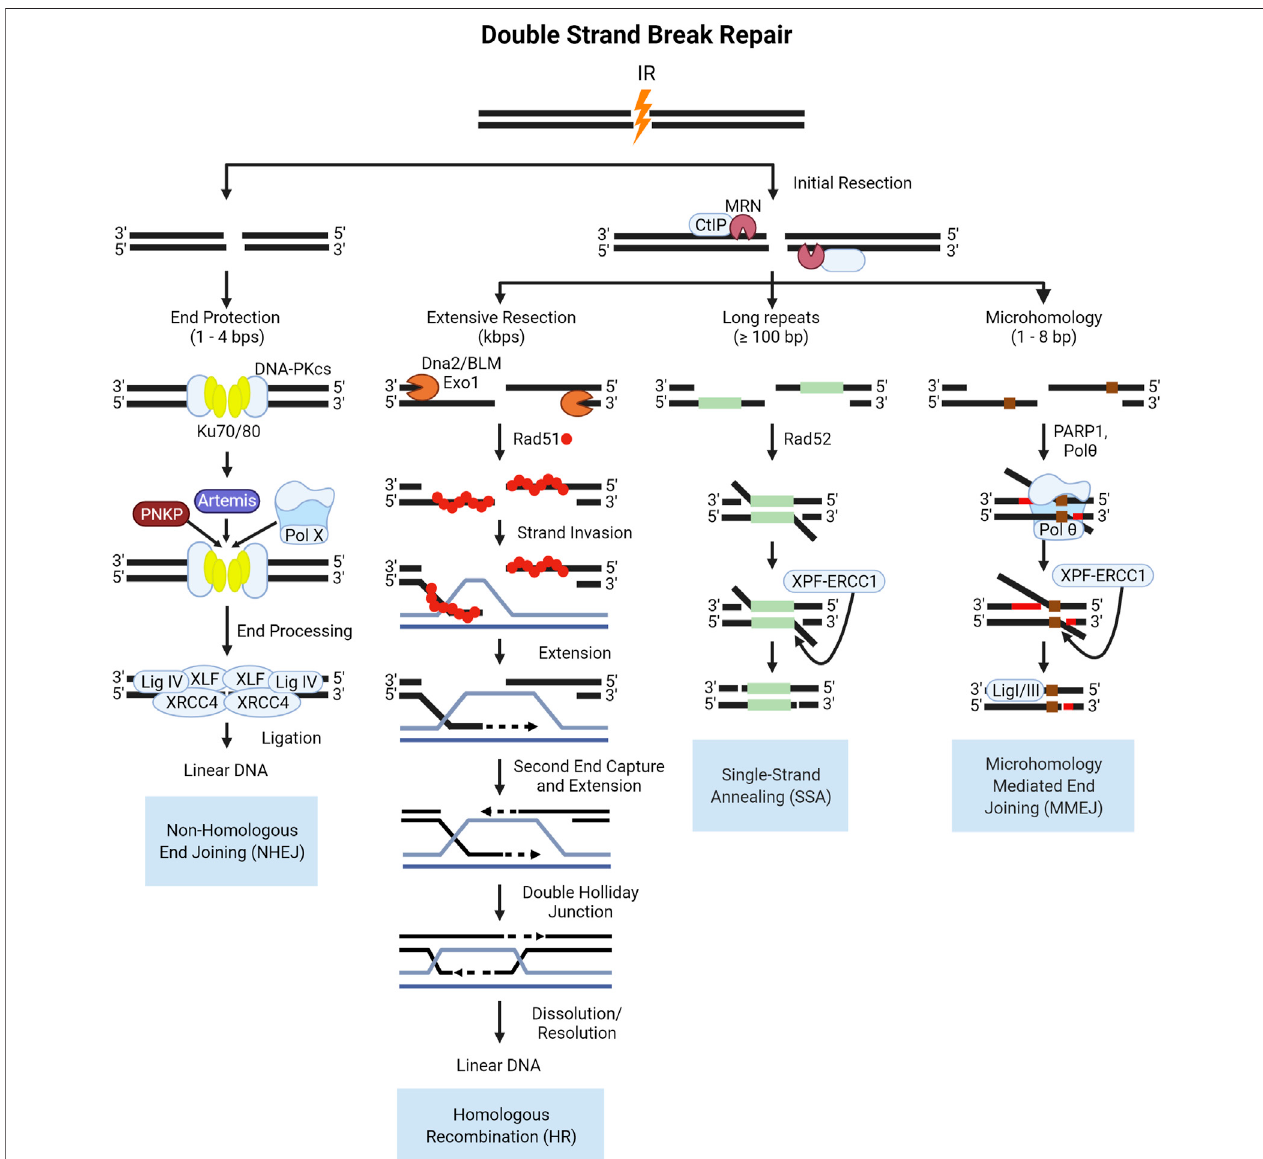
FIGURE6| SchematicofendprotectedandresectiondependentDNAdoublestrandbreak(DSB)repairpathways.NHEJisinitiatedbythebindingoftheKu70/80 heterodimerwhichrecruitsDNA-PKcs,akinasewhichfunctionstotetherthebreakendsandrecruitthefactorsinvolvedinendprocessingandligationshownhere.InS- and G2, the increase in active cyclin dependent kinases (CDKs) in complex with cyclins phosphorylate key proteins like the resection mediating factor, CtIP which activates the nuclease activity of MRE11 in the MRN complex (Huertas et al., 2008; Makharashvili et al., 2014). The subsequent resection is the key event that commits a DSB to HR repair, producing single stranded 3 ′ -DNA ends, which cannot be ligated by NHEJ (Williams et al., 2009; Himmels and Sartori 2016). Resected DNAisconvertedintoapre-synaptic fi lamentwiththereplacementofRPAbytheRad51recombinaseprotein,whichthensearchesforhomology(Thorslundetal.,2010; Maetal.,2017;SullivanandBernstein2018).Oncehomology isfound,the fi lamentinvadestheduplexDNAandthestrand iselongated throughsynthesis(McVeyetal., 2016; Wright, Shah, and Heyer 2018; Tavares et al., 2019). After the second end is captured and synthesized the resulting four strand structure, the double Holliday Junction, can then be dissolved or resolved (Svendsen and Harper 2010; Wyatt et al., 2013; Bizard and Hickson 2014; Wyatt and West 2014). In lieu of rad51 fi lament formation,inSSARad52functionstoannealhomologousDNAsequencesandisalwaysassociatedwiththedeletionofDNAbetweenthetworegionsofhomology.The resulting fl ap of DNA is subsequently removed by the XPF-ERCC1 nuclease complex after DNA ligation, which is enhanced by the presence of Rad52 (Motycka et al., 2004; Bhargava, Onyango, and Stark 2016). The occurrence of MMEJ has been correlated to the length of the 3 ′ overhang end, with longer ends of 45 – 100 bps being ideal for Polymerase θ (Pol θ ) helicase to act on the single stranded ends, facilitating the annealing of these ends as well as low fi delity polymerase activity for extension (Wyatt et al., 2016; Black et al., 2019). After extension, the 3 ′ - fl ap overhangs are trimmed by the XPF-ERCC1 nuclease complex, and fi nally annealing is performed by Ligase